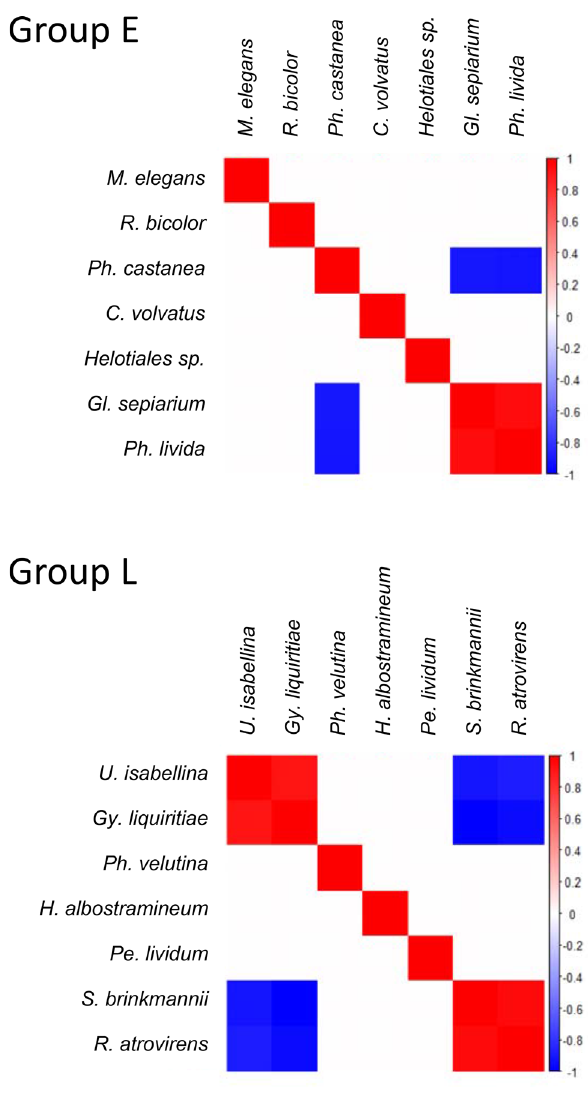
Figure 3. Association networks of fungal OTUs in groups E and L, according to sequence read number. Positive associations are displayed in red, and negative in blue. Only associations with a posterior probability above 95% are colored. OTUs were ordered to optimize visualization of association